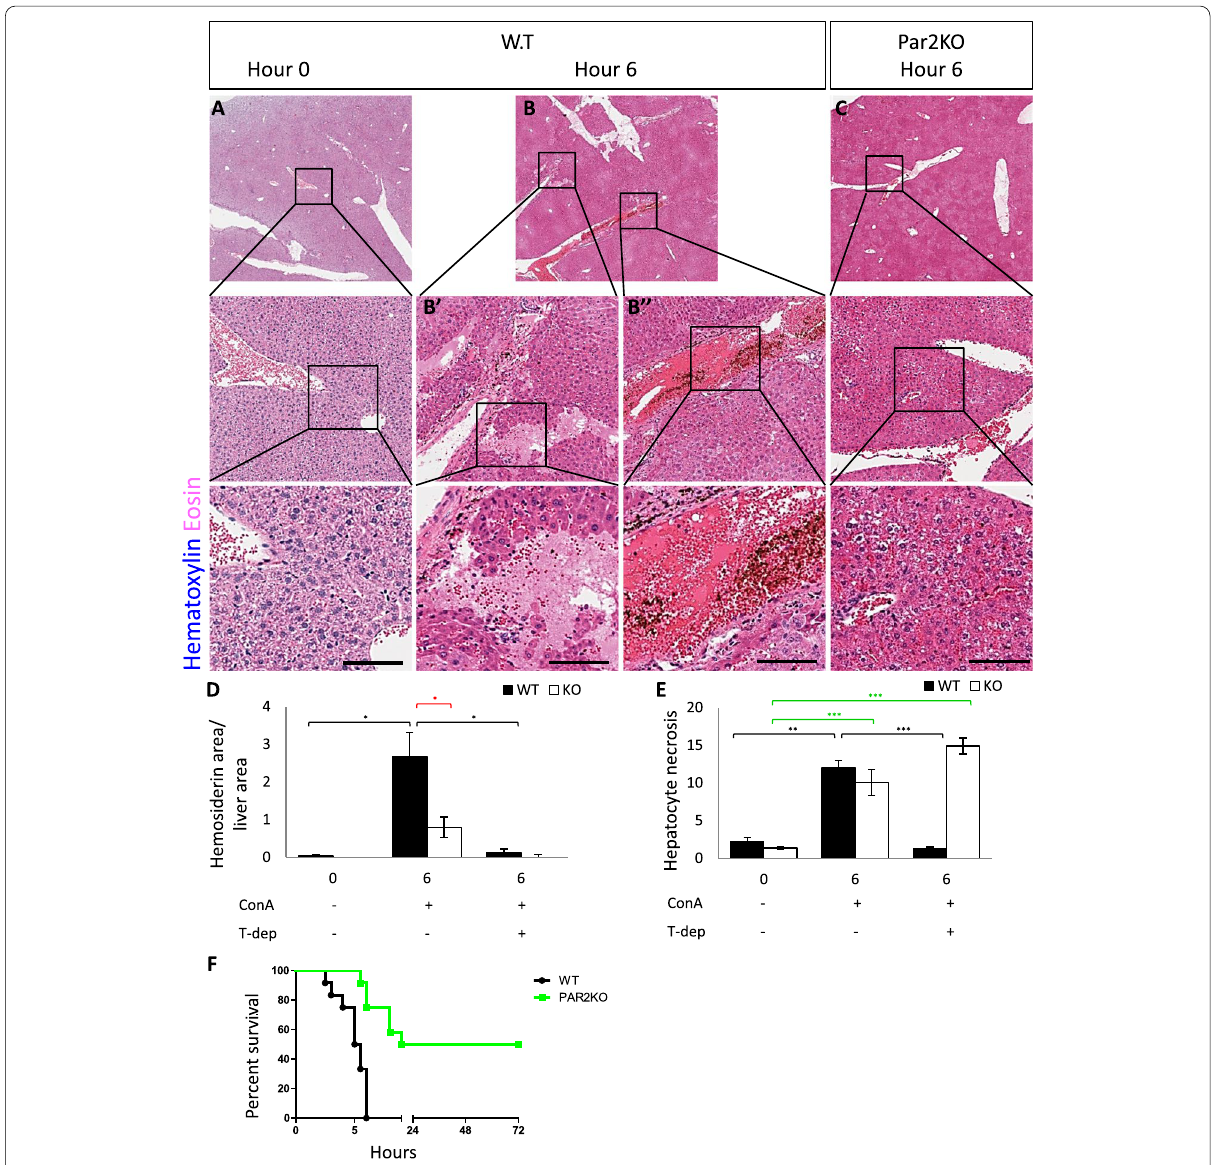
Fig. 4 Par2KO improves survival from high-dose ConA-induced hepatitis. High-dose ConA (15mg/kg) induced acute liver lesions in all mice by 6 h after injection ( A – C ). Extensive hemorrhage was present in WT ( B ), but not in Par2KO ( C ) mice, 6 h after injection of ConA. Scale bar for A – C = 75μm. D , E T cell depletion rescued WT liver from damage—quantification of the data presented in supplemental fig 7. D Liver hemosiderin area was significantly greater in WT than in Par2KO mice 6 h after high-dose ConA injection (15 mg/kg, n 24, n 4 for each group). Following T cell = = depletion, there was no hemosiderin in the KO and almost none in the WT mice. E Hepatocyte necrosis appeared both in WT and Par2KO mice 6 h after high dose of ConA injection. T cell depletion diminished hepatocyte necrosis in the WT mice, while in the KO necrosis remained similar. Statistical significance was measured using T test. *Indicates p <0.05, ** p <0.01, *** p <0.005, error bars SEM. Black—between the WT groups; Red— = in D , hemosiderin differences between WT and KO 6 h after ConA injection without T cell depletion. Green—in E , between the Par2KO groups. F Kaplan-Meier survival plot of WT (black, n 12) and Par2KO (green, n 12) after 15mg/kg ConA injection. Log-rank (Mantel-Cox) test for p value = = =